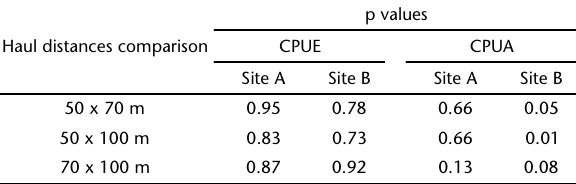
Table II. The resulting p values from Kruskal-Wallis post-hoc test for CPUE and CPUA between the different haul distances (50, 70, and 100 m), for each sampling site (A and B).